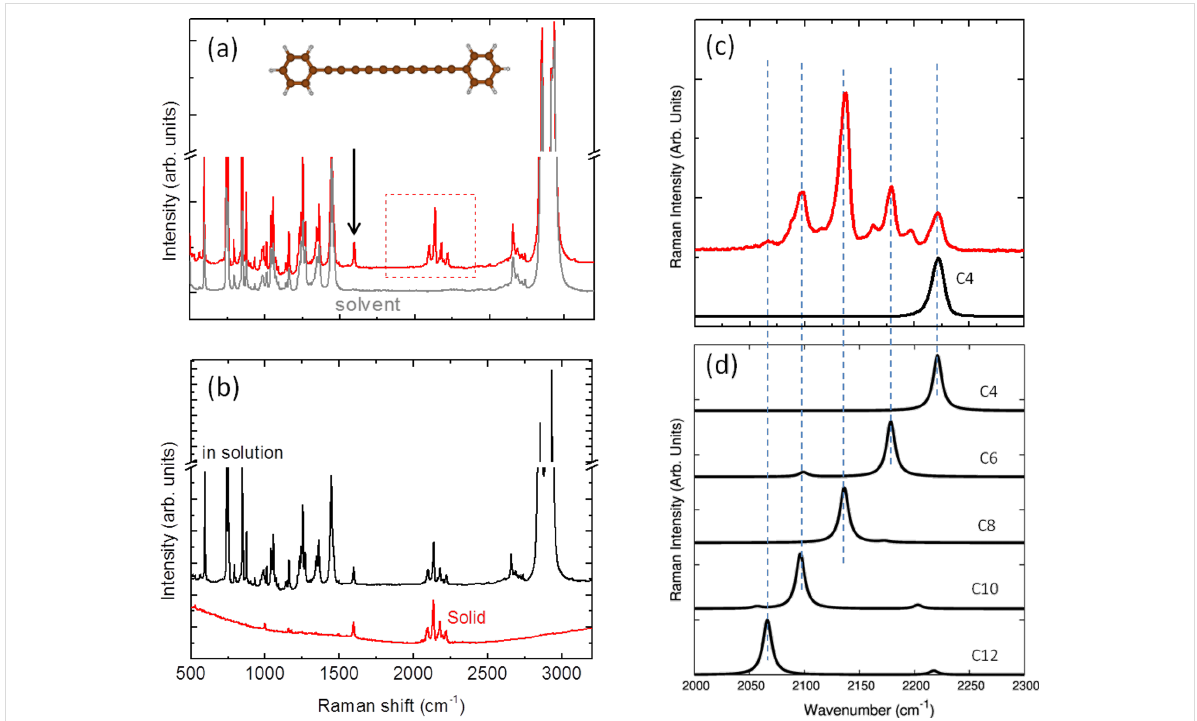
Figure 5: (a) Experimental Raman spectrum (1064 nm) of phenyl-capped polyynes in decalin (10 − 2 M) with the pure solvent shown for comparison. The peak related to the phenyl termination is marked with an arrow. (b) The Raman spectrum of phenyl-capped polyynes after solvent removal to show the stability of the sample. (c) Detail of the experimental Raman spectrum of panel (a). The spectrum of size-selected phenyl-capped polyyne with 4 carbon atoms is also reported. (d) Peaks corresponding to different wire lengths according to DFT calculations of the Raman modes [39]. Figure adapted with permission from [39], copyright 2011 American Chemical Society.